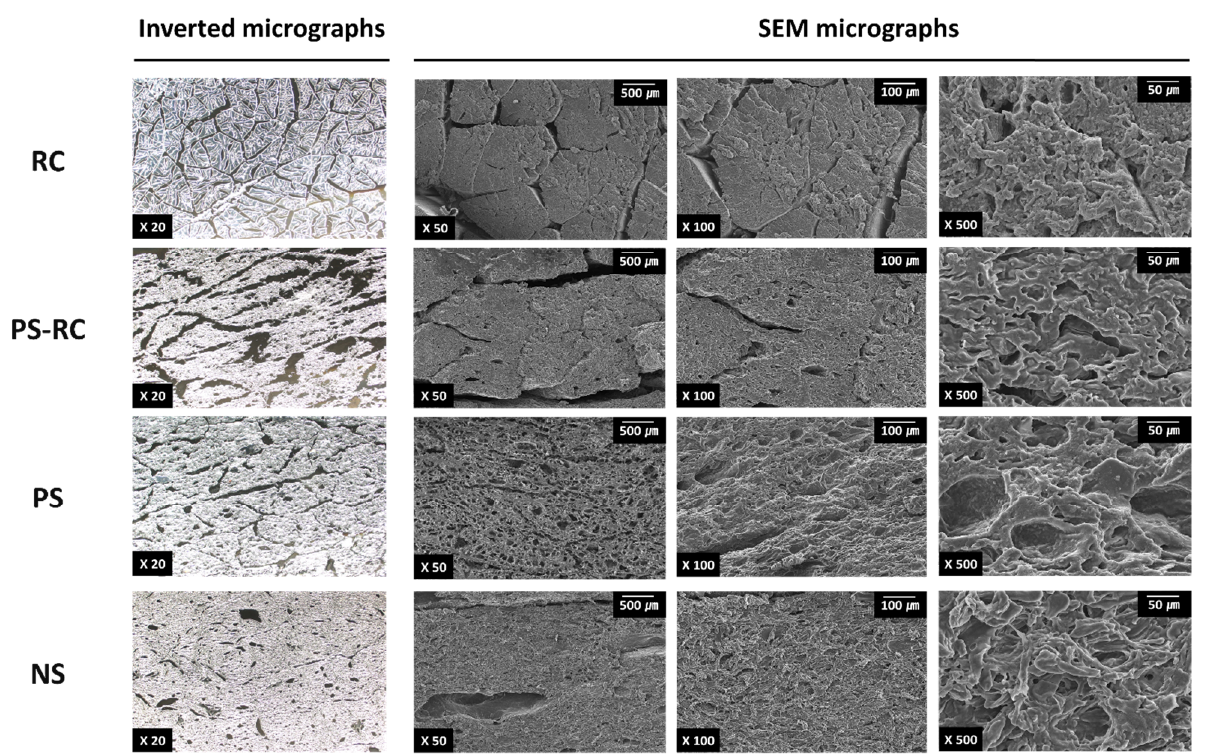
Figure 3. Inverted and SEM micrographs of real snow crab ( C. opilio ) leg meat (RC) and commercial imitation crab sticks (ICSs). Left to right, the magnifications are ×20, ×50, ×100, and ×500. PS-RC, premium ICS with real red snow crab ( C. japonicus ) leg meat; PS, premium ICS without real red snow crab leg meat; NS, normal ICS.